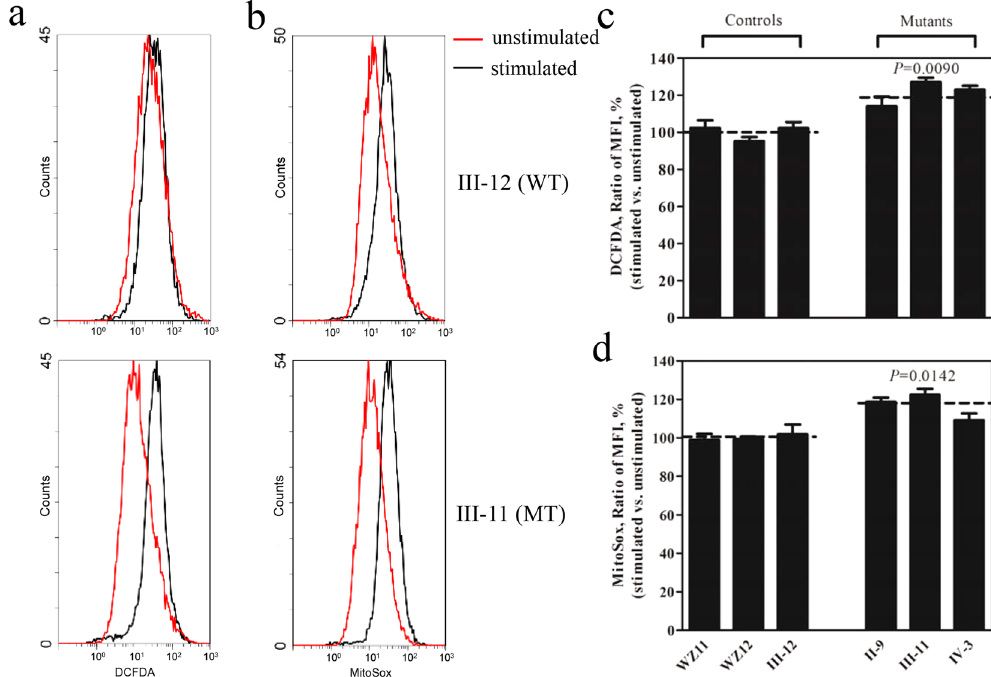
Figure 7. Ratio of geometric mean intensity between levels of the ROS generation in the vital cells with or without H 2 O 2 stimulation. The rates of production in ROS from three mutant cell lines and three control cell lines were analyzed by FC500MCL flow cytometer system (Beckman) using ( a ) DCFDA (20 mM) and ( b ) MitoSox (5 mM), either without (Red) or with (Black) H 2 O 2 stimulation. The relative ratio of intensity (stimulated versus unstimulated with H 2 O 2 ) was calculated. ( c ) Total ROS generation in the vital cells and ( d ) mitochondrial ROS generation. The average of three independent determinations for each cell lines is shown. Graph details and symbols are explained in the legend to Fig.